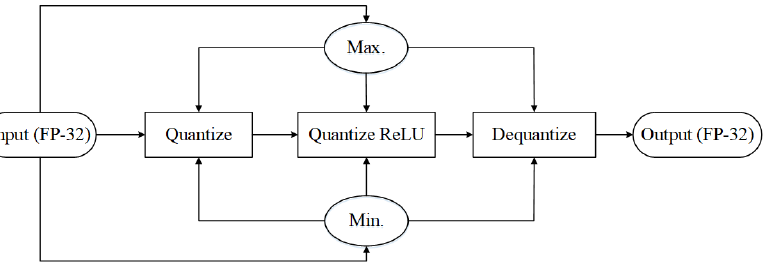
Figure 5. Schematic Flow Diagram: Quantization Algorithm of Deep Learning